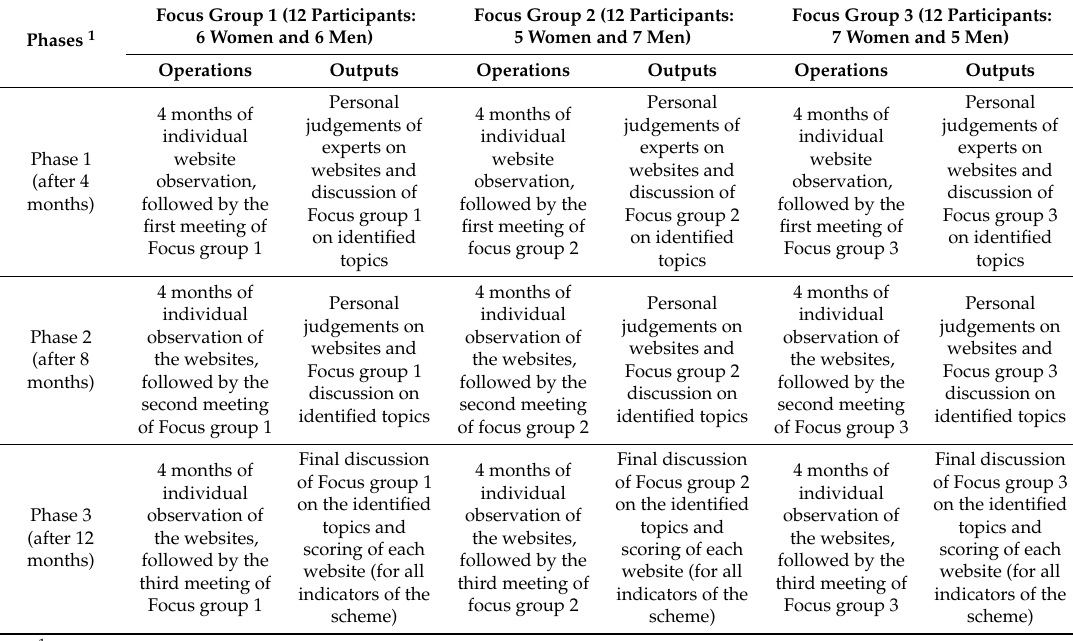
Table 2. Design and phases of focus groups analysis both for the Etna and the Pantelleria wineries’ websites. Data collected from all three focus groups (total 36 experts: 18 women and 18